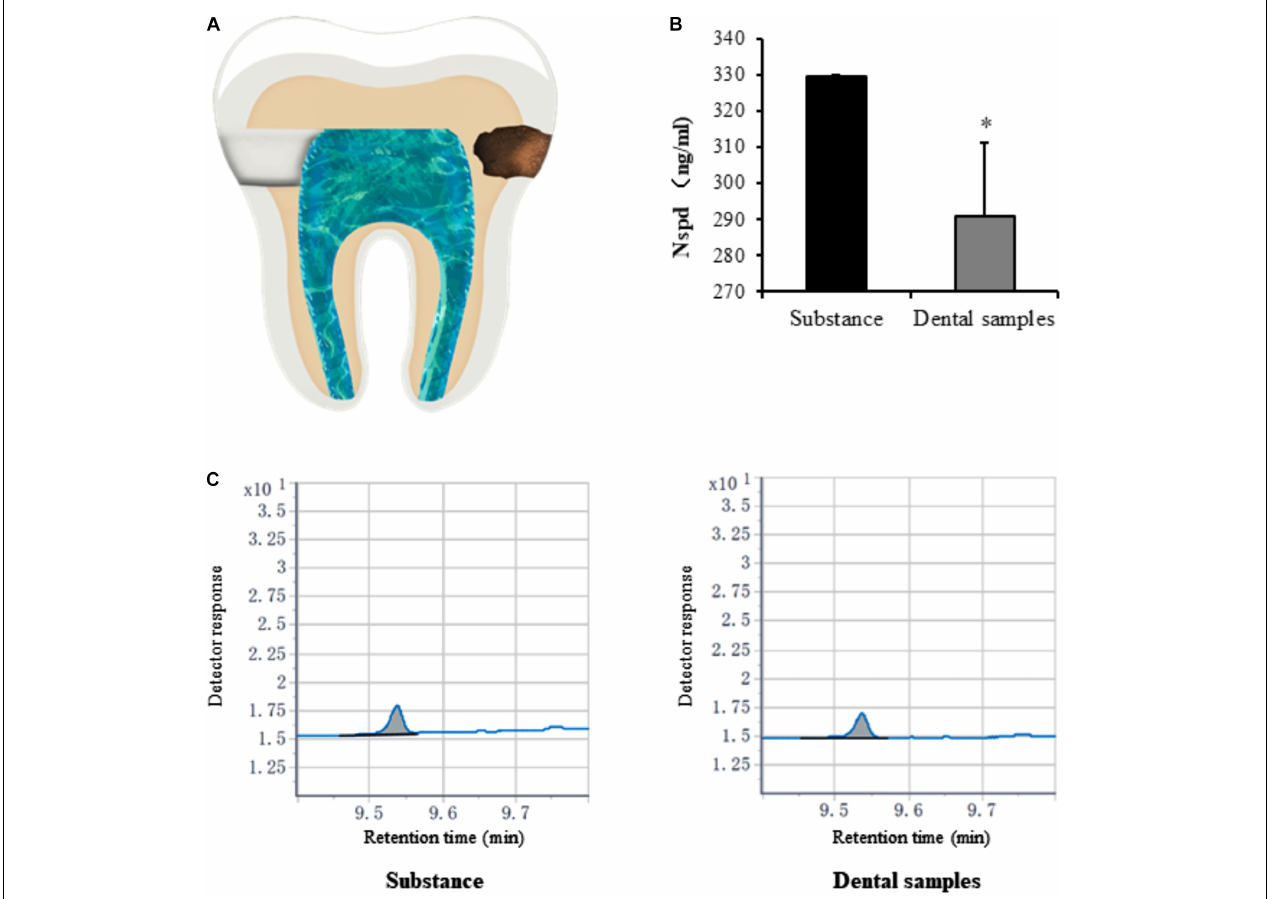
FIGURE 7 | Quantification of norspermidine in dental caries model in vitro . (A) The opening location of pulp chamber (left side) and Cavity of tooth (right side) in dental caries model. (B) Nspd was quantified according to the peak area detected with Agilent GC system. * represented dental samples group was significantly different from substance group. Data were presented in the mean ± standard deviation; * p < 0.05. (C) Detector response of Nspd. Substance group was diluted 250 times with 0.63 mM Nspd, and the dental sample was also diluted 250